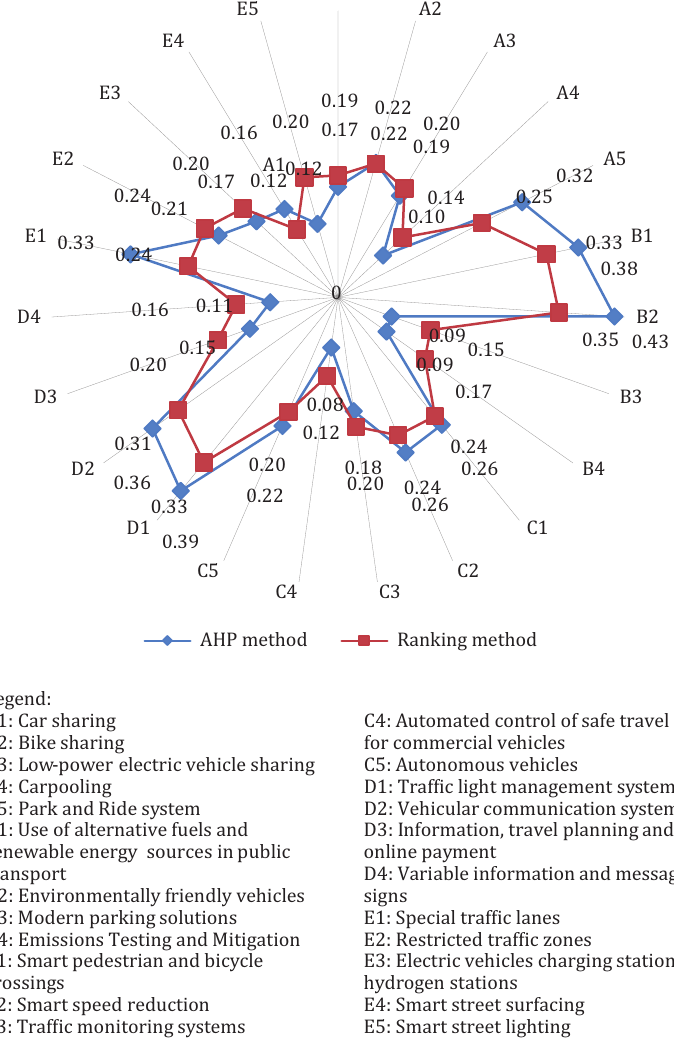
Figure 2. Comparison of criteria weights calculated by different